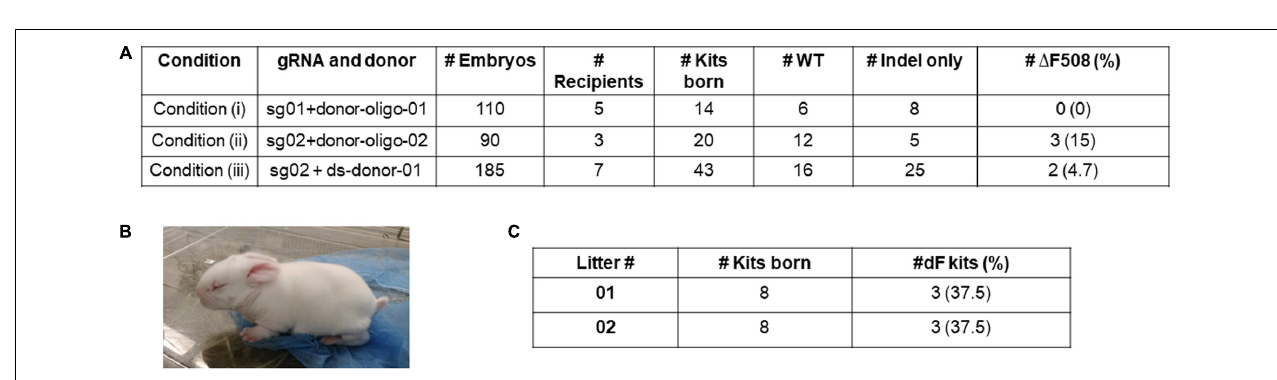
FIGURE 2 | Production of (cid:49) F508 founder rabbits. (A) Summary of embryo transfer and genotyping results. (B) One founder (cid:49) F508 kit. (C) Summary of breeding outcome to generate F1 generation (cid:49) F508 rabbits. #Indel only refer to number of animals that carry non- (cid:49) F508 indel mutations. # (cid:49) F508 refers to number of animals that carry (cid:49) F508